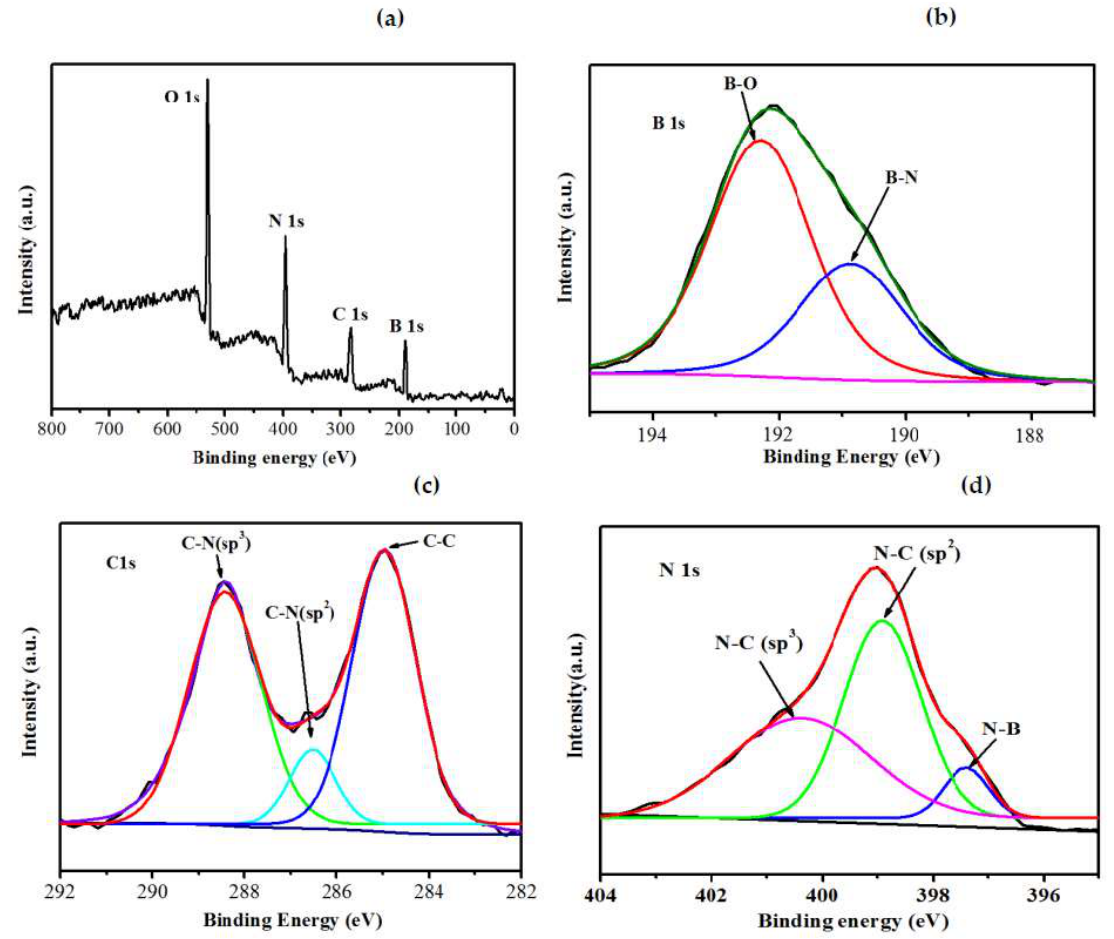
Figure 7. XPS survey spectra of ( a ) product and the deconvoluted spectra of ( b ) B1s, ( c ) C1s, ( d ) N1s. To investigate the generation of the B 2 O 3 , CN, and B 2 O 3 /CN series samples, thermo gravimetric analysis was performed from room temperature to 800 °C at a heating rate of 10 °C min −1 in N 2 flow.